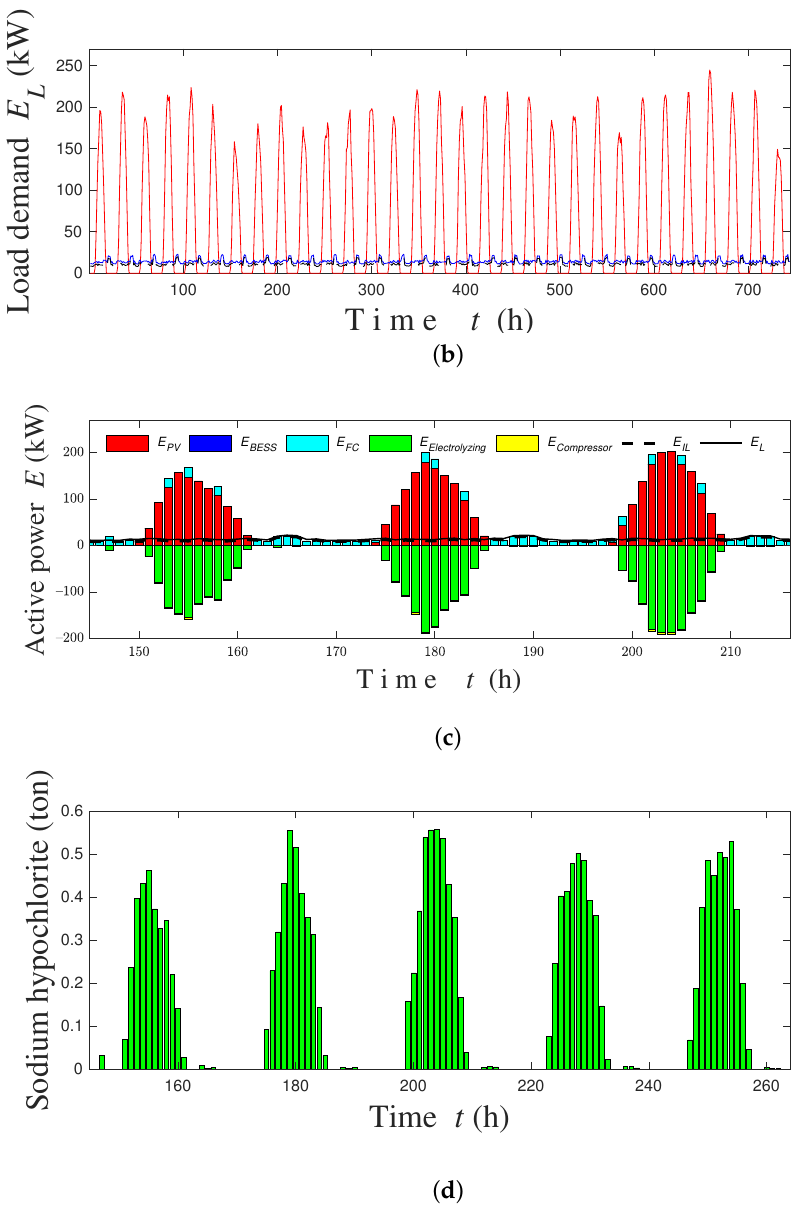
Figure 6. Simulation results of case 3. ( a ) The per hour PV generation. ( b ) The trends of PV power and load demand. ( c ) The simulation results for 5 days. ( d ) The generation of NaOCl in 5 days. iv. Case 4: In this case, ADLC was applied to the consumers who had rooftop PV. Table 15 shows the results of this case. Figure 7a shows the one month PV generation. Trends of PV generation and load demand are shown in Figure 7b. The 5-days optimal configuration of installed equipment and the production of NaOCl are shown in Figure 7c,d